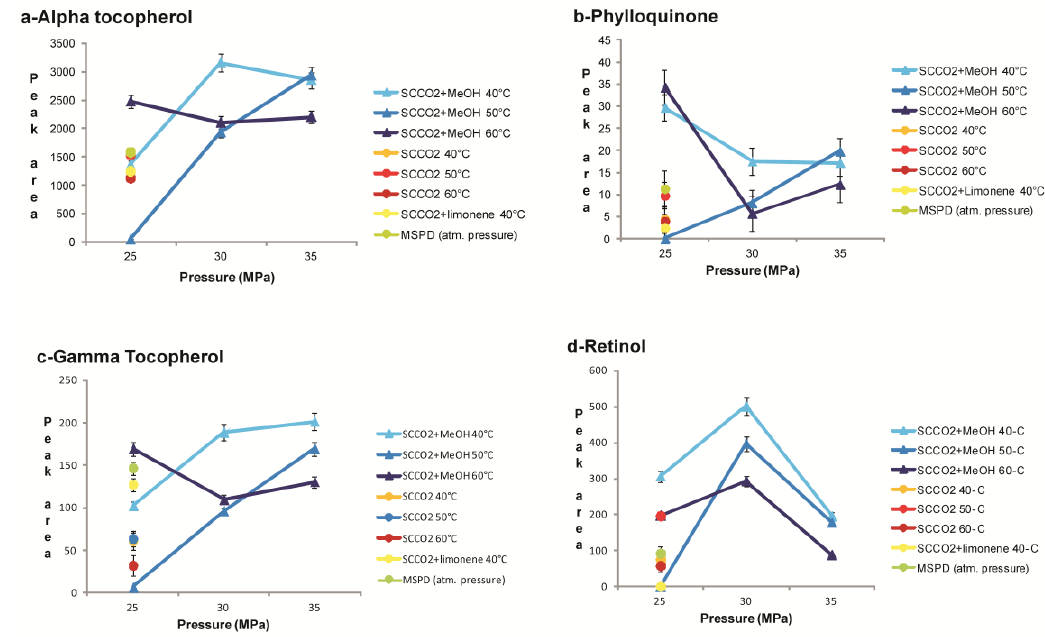
Figure1. Extractionyields(averagepeakarea ± standarderror)of( a )alphatocopherol, ( b )phylloquinone, Figure 1. Extraction yields (average peak area ± standard error) of ( a ) alpha tocopherol, ( b ) ( c ) gamma tocopherol, and ( d ) retinol obtained with SFE and phylloquinone, ( c ) gamma tocopherol, and ( d ) retinol obtained with SFE and MSPD.